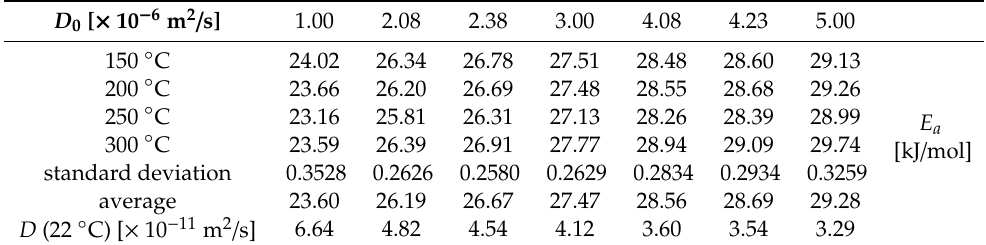
Table 6. Extract from the